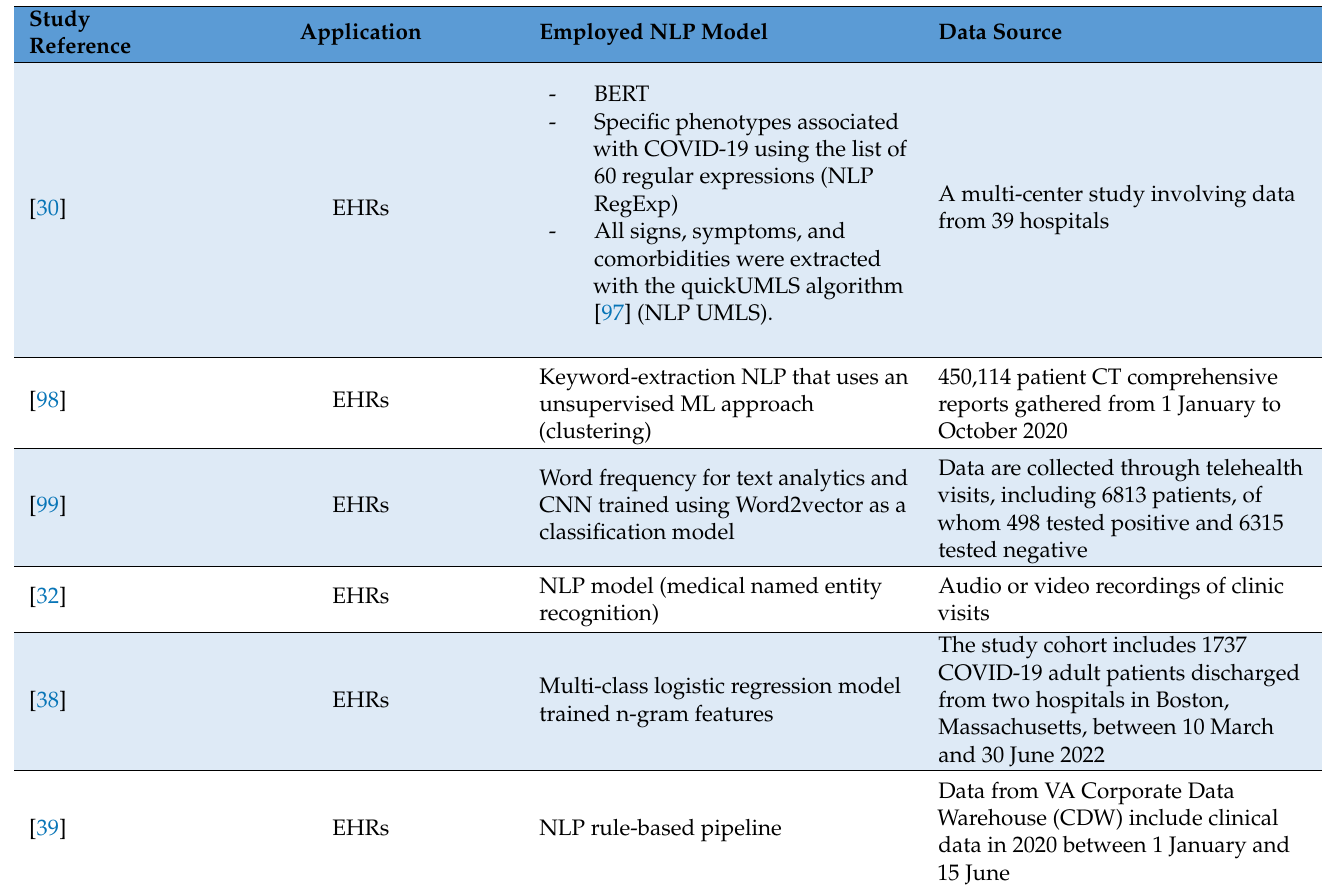
Table 1. Comparison of studies that apply NLP to various applications related to